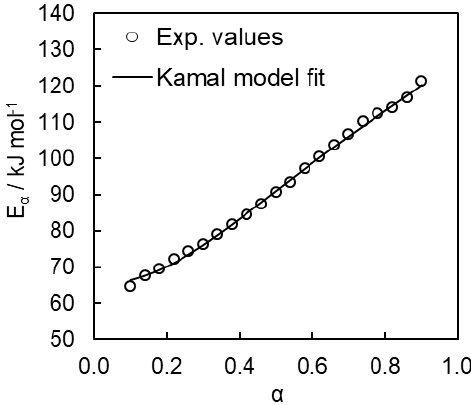
Figure 10. Fitting of the Kamal model to the experimental E α dependence for bulk polymerization.